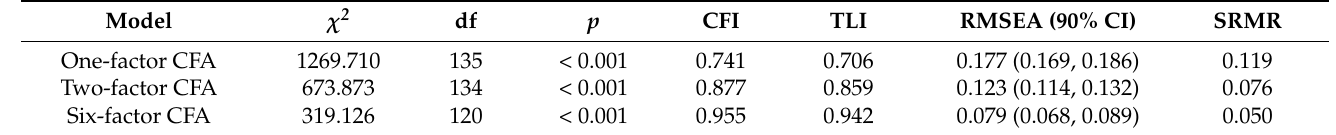
Table 3. Goodness-of-fit indices for the estimated solutions for the SSCS-L.